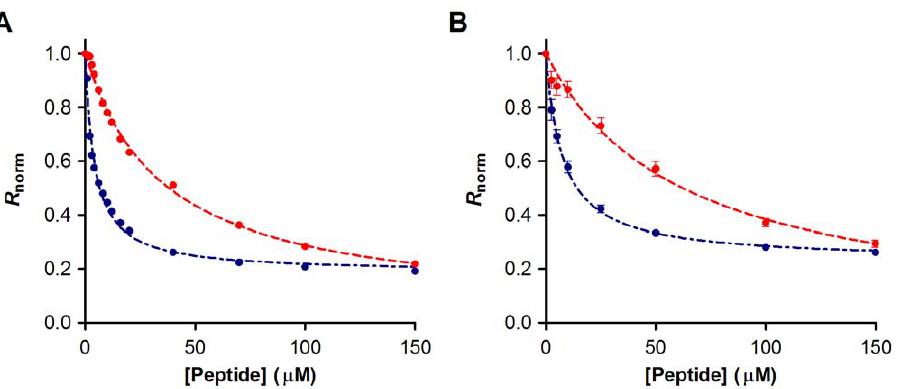
Figure 4. Peptide affinity towards erythrocytes and PBMC cell membranes. The dependence of the ratio on the enfuvirtide (red) and T-1249 (blue) concentrations for erythrocytes (A) and PBMC (B) was analyzed by a single binding site model (dashed lines) in order to quantify the dissociation constants (see Table 1). Ratio values were normalized for the initial value of zero peptide concentration. Plotted values represent the mean 6 SEM (error bars not visible in erythrocytes due to small errors). N=6 for erythrocytes and N=7 for PBMC.